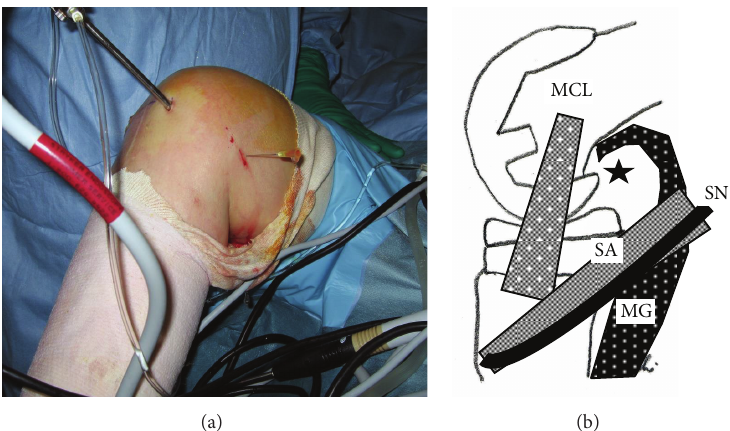
Figure 2: (a) Operative procedure to determine the site of the posteromedial portal. A 22-gauge needle was inserted at the edge just posterior to the medial aspect of the femoral component. Note the drops of irrigation solution dripping from the inserted needle. (b) The black star indicates the position of the posteromedial portal. MCL: medial collateral ligament; MG: medial head of the gastrocnemius muscle; SA: sartorius; SN: saphenous